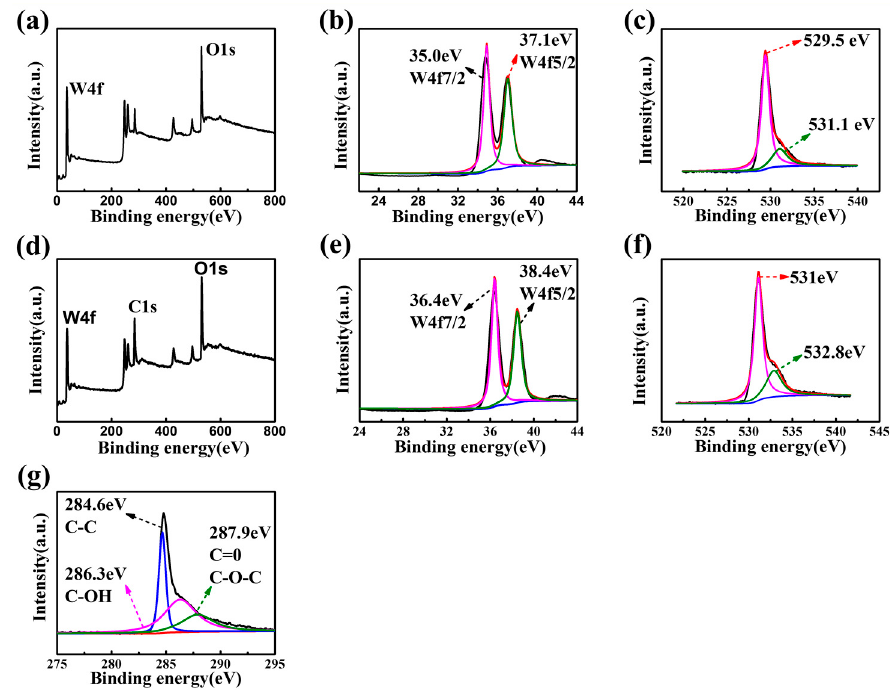
Figure 5. ( a ) The XPS full spectrum; and X-ray photoelectron spectra of: ( b ) W4f; and ( c ) O1s for pure WO 3 ; ( d ) The XPS full spectrum; and X-ray photoelectron spectra of: ( e ) W4f; ( f ) O1s; and ( g ) C1s for the WO 3 /GR-0.1 nanocomposite.